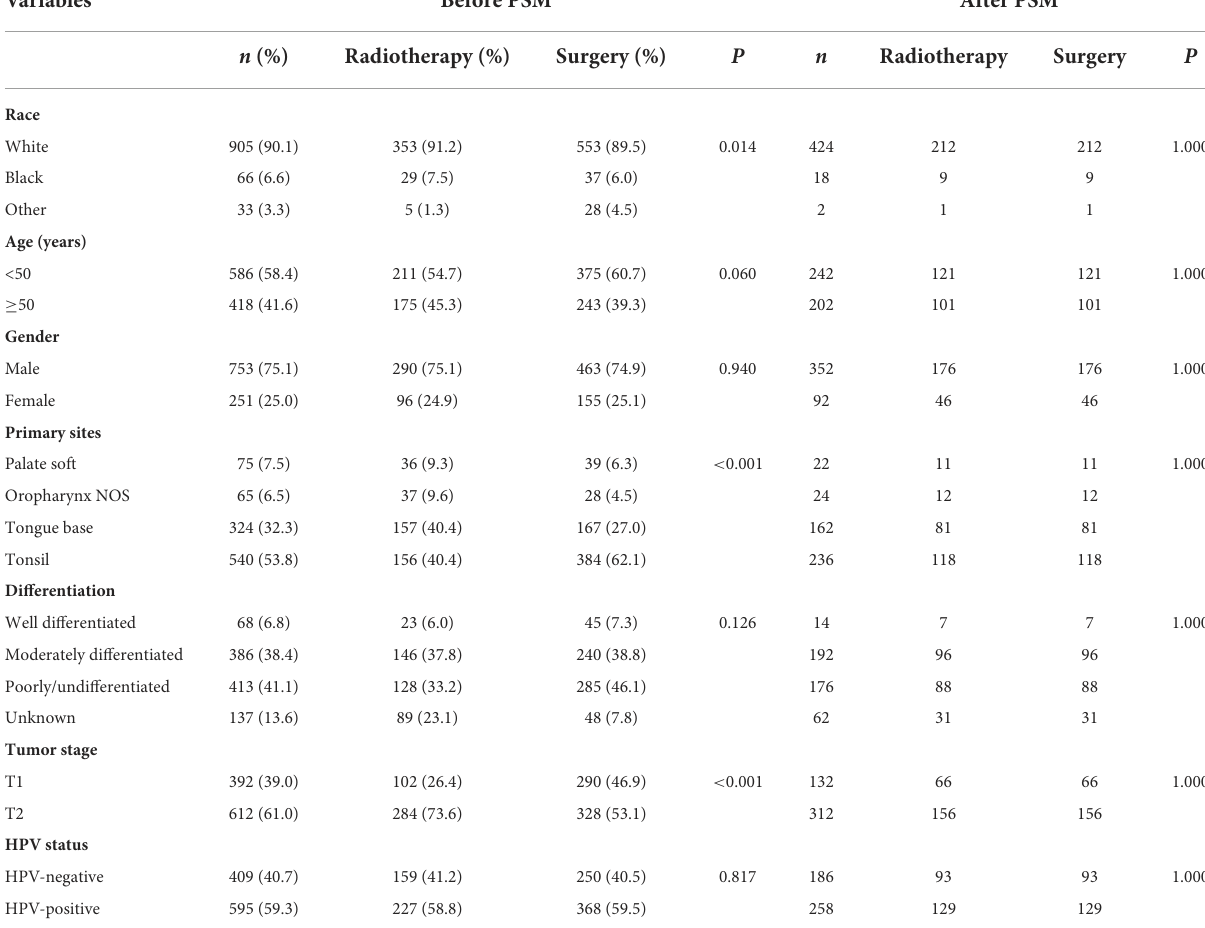
TABLE 1 Patients and treatment characteristics by treatment strategies before and after propensity matching analysis.